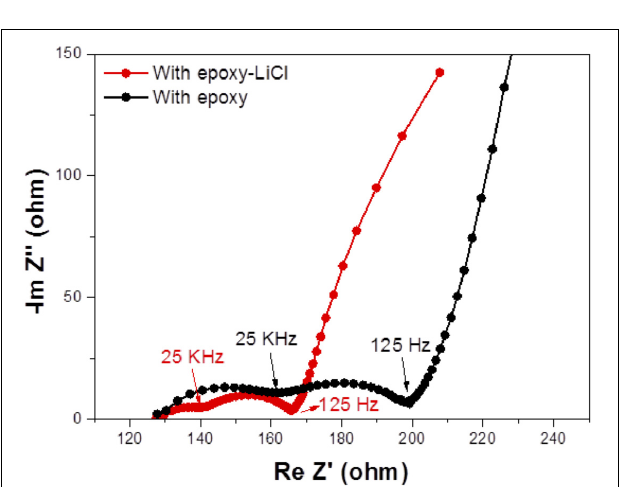
FIGURE 10 | Cycle performance of the Li/(LiFSI-2G4)–50 vol% DOL/LAGTP with epoxy resin and LiCl/saturated LiOH and LiCl aqueous solution/KB, air cell at 0.5 mA cm − 2 and